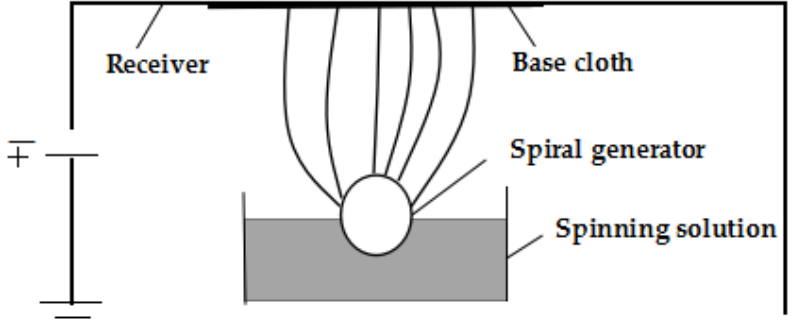
Figure 1. Schematic diagram of spiral vane electrostatic spinning machine.